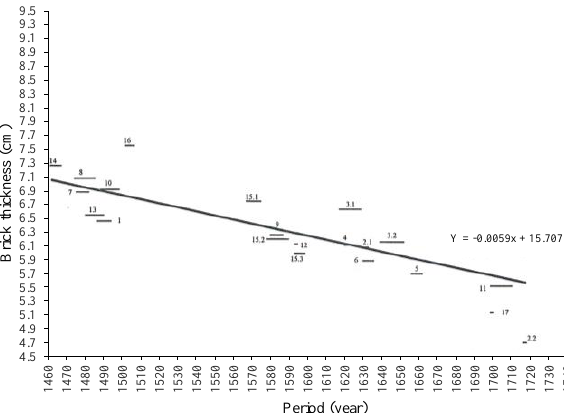
Figure 1. The mensiochronologic curve of the city of Milan and its surroundings (Casolo Ginelli 1998: 57)